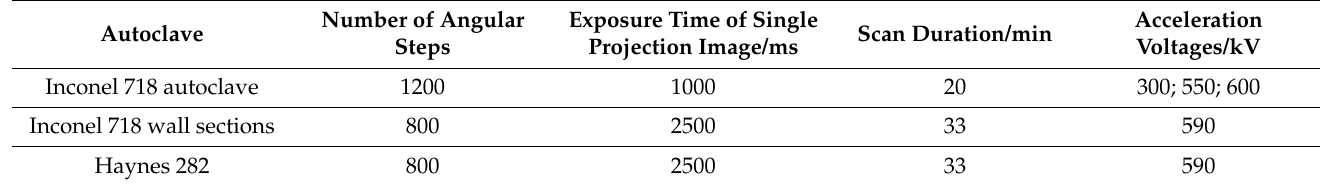
Table 2. Experimental parameters of the ex situ CT measurements. The wall thickness t was 14.5 mm for the Inconel 718 and Haynes 282 autoclave. Thicknesses tested additionally using wall